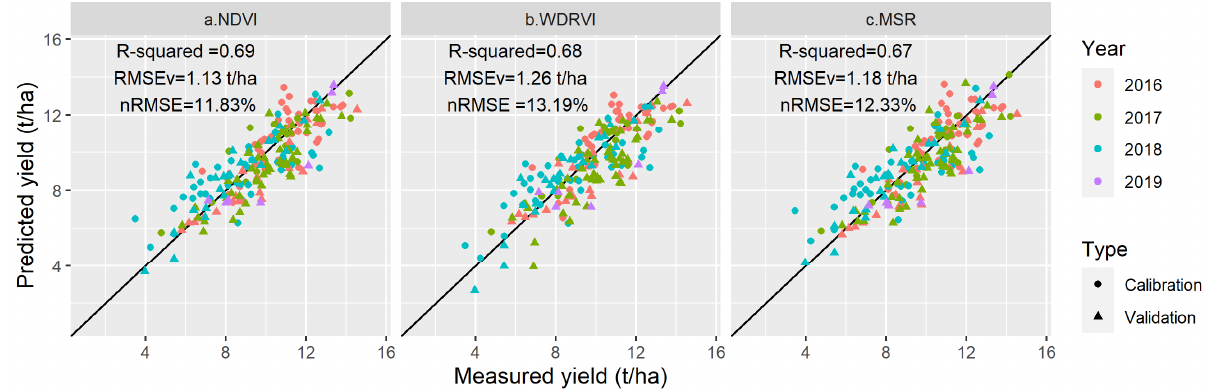
Table 6. Coefficient value of each variable in yield model by multiple linear regression (MLR).